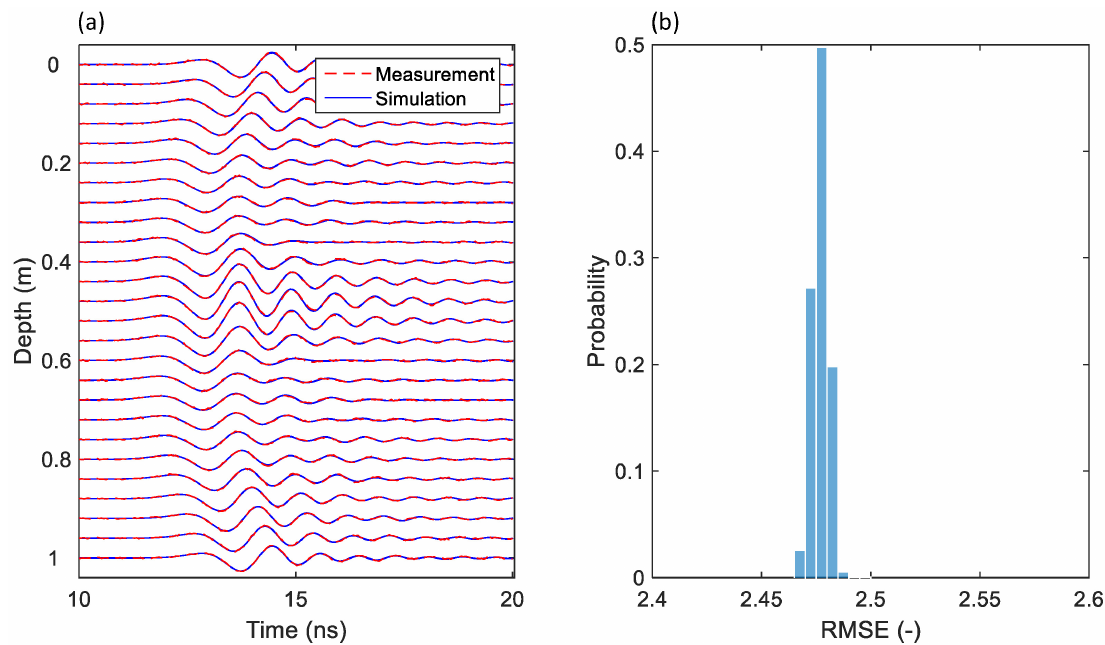
Figure 10. Fitting of the measurement data by the posterior models derived from Bayesian inversion using the FDTD forward model: ( a ) measured and simulated waveforms, and ( b ) histogram of the RMSE values of the posterior